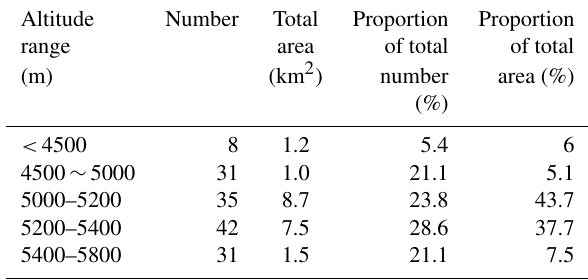
Table 3. Area distribution of glacial lakes in the Poiqu River basin. Area Total